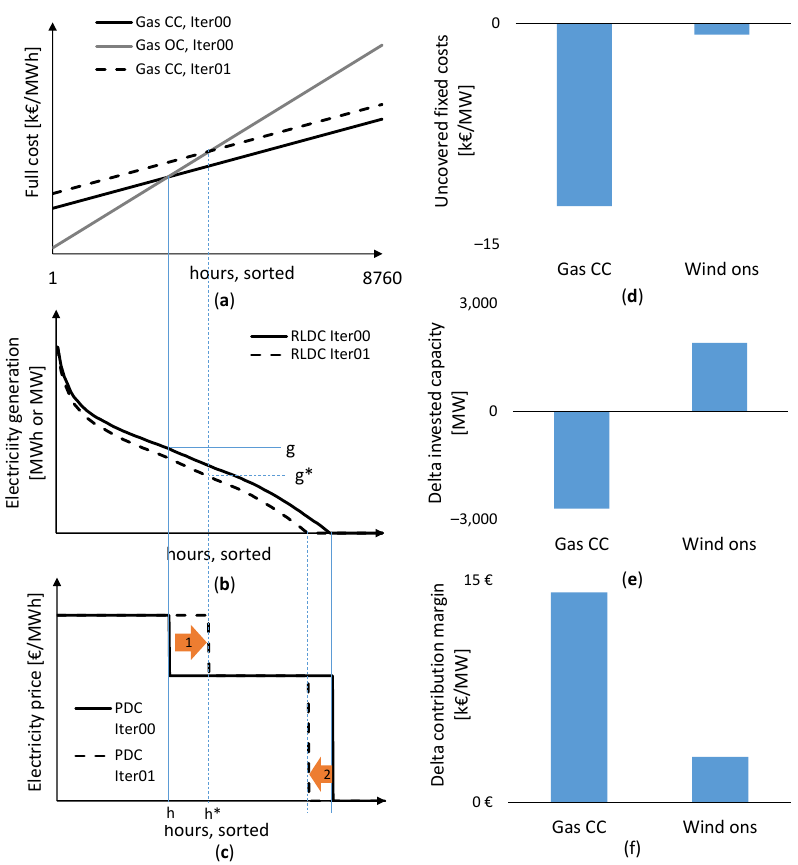
Figure A1. Exemplified effects of the invest premium. For iteration 0 and 1 respectively: ( a ) Full cost curves; ( b ) Residual load curves and optimal investment; ( c ) Resulting price duration curves; Delta for new technologies between iteration 0 and 1: ( d ) Uncovered costs per MW; ( e ) Cost-optimal capacities; ( f ) Contribution margins.